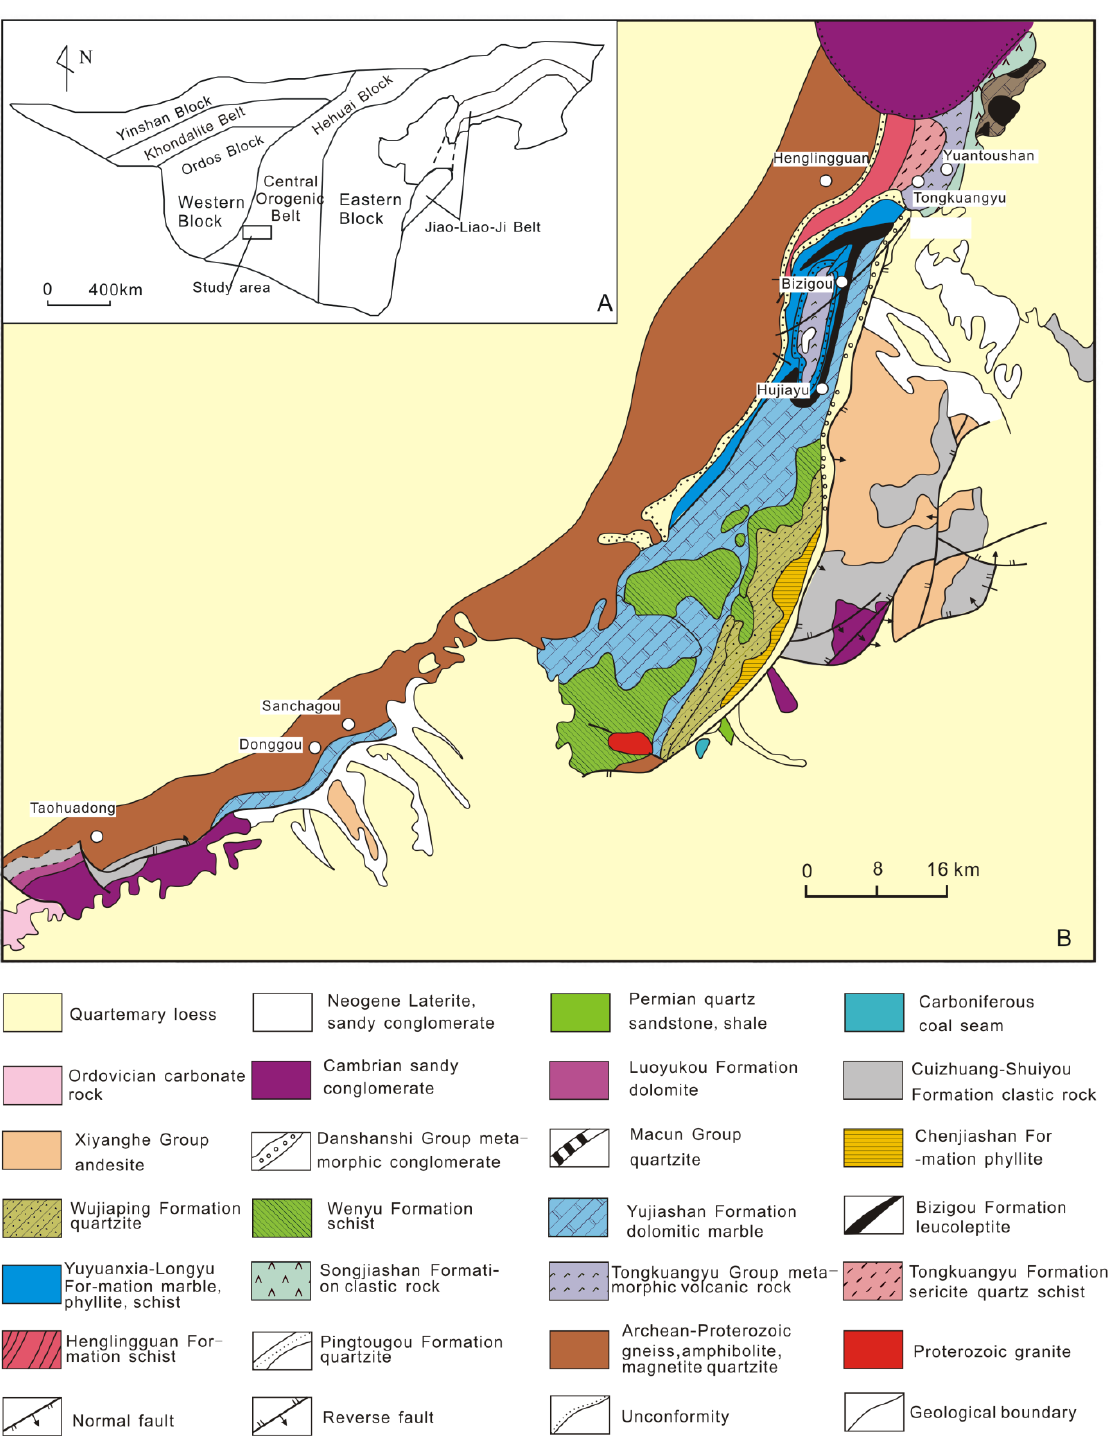
Figure 1. Simplified geotectonic map of study area ( A ) and Regional geological map of Zhong- tiaoshan ( B ) (modified after CGGCDZM, 1978 [1]).